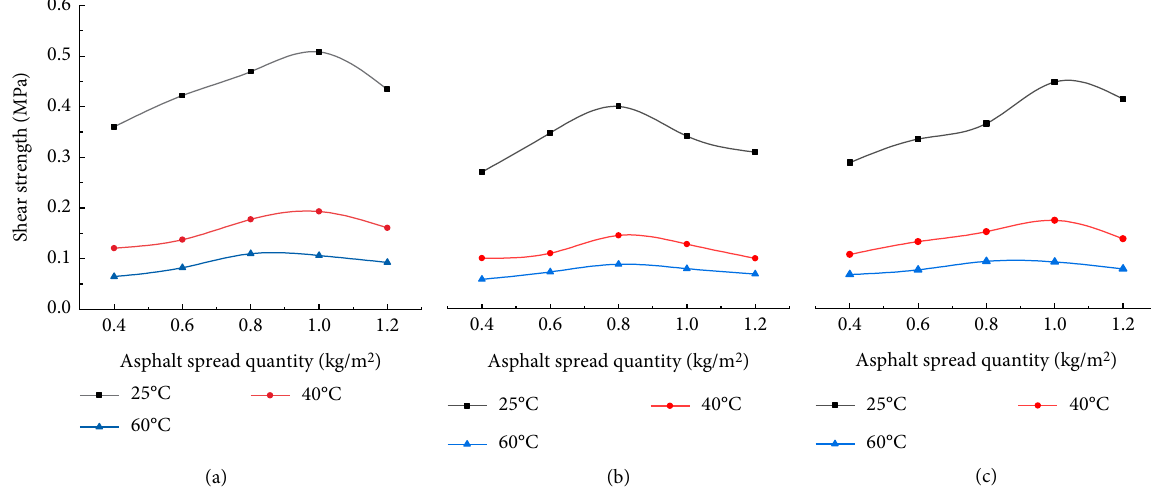
Figure 14: Shear strength of specimens with geotextiles interlayer treatment: (a) SBS-modified asphalt, (b) ordinary hot asphalt, (c) SBS- modified emulsified asphalt.